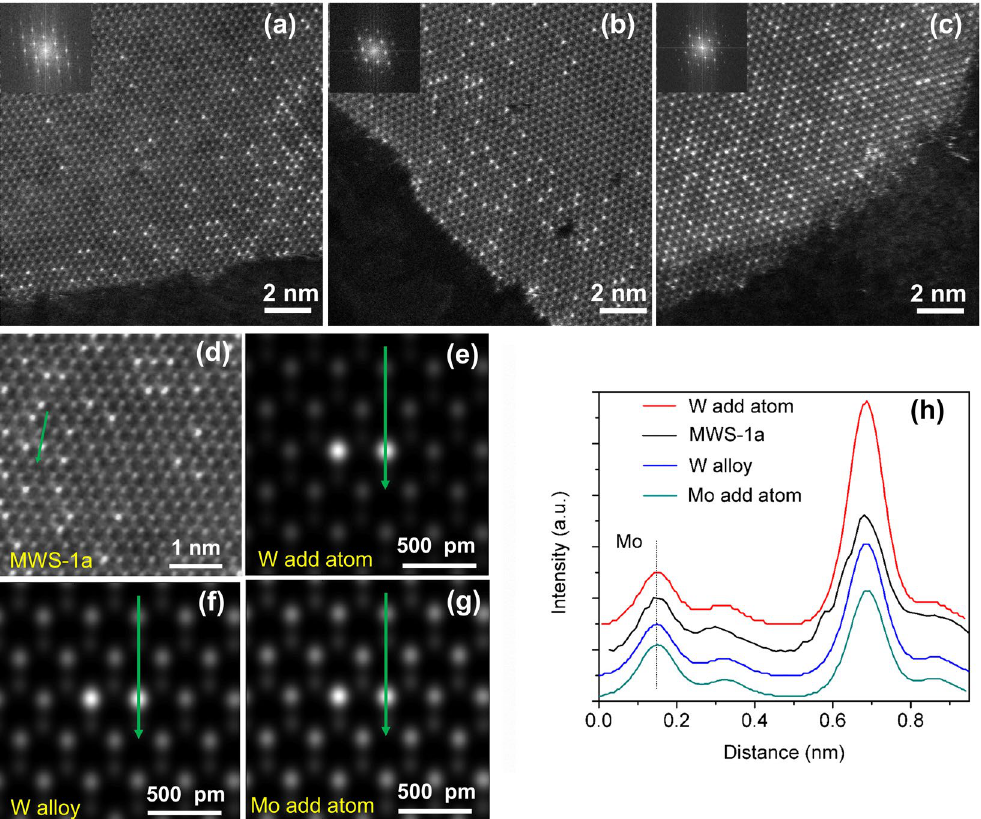
Figure 2. A typical atomic-scale ADF-STEM images of MWS-1a, MWS-1b and MWS-1c are displayed in ( a ), ( b ) and ( c ), respectively. MWS-1c contains highly concentrated W doping at the edges of MoS 2 layers compared to MWS-1a and MWS1-b. ( d ) The experimental image of a selected region of W doped MoS 2 structure within MWS-1a and the corresponding line profile. ( e – h ) The simulation images and the corresponding line profiles. The intensity of line profile in ( d ) matches with the line profile in ( f ) confirms that the W atoms are doped into the MoS 2